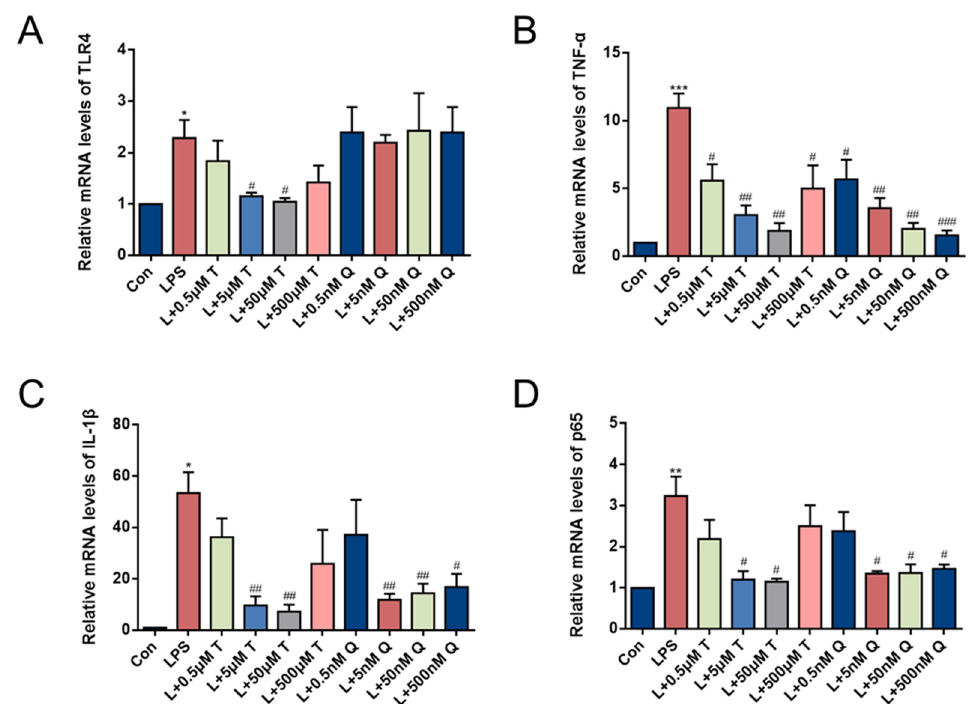
Figure A5. Concentration screen of TLR4 inhibitor TAK-242 and NF- κ B inhibitor QNZ. L = LPS, T = TAK-242, Q = QNZ. ( A ) mRNA expression levels of TLR4. ( B ) mRNA expression of TNF- α . ( C ) mRNA expression of IL-1 β . ( D ) mRNA expression of p65. * or # represent significant difference compared with Con or LPS group. * or # p < 0.05, ** or ## p < 0.01, *** or ### p < 0.001.